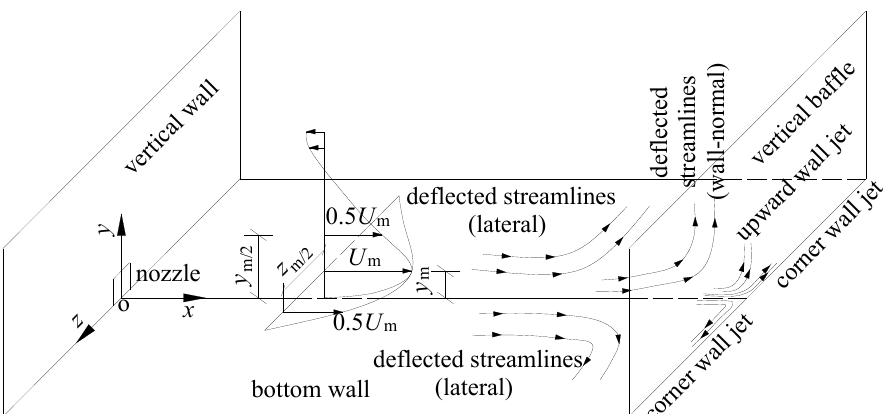
Figure 1. Schematic diagram of a three-dimensional wall jet confined by a vertical baffle.